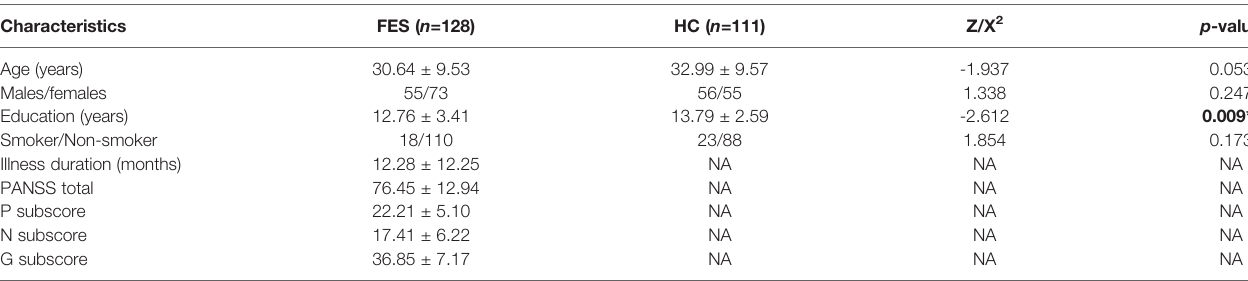
TABLE 1 | Participant demographic and clinical characteristics.